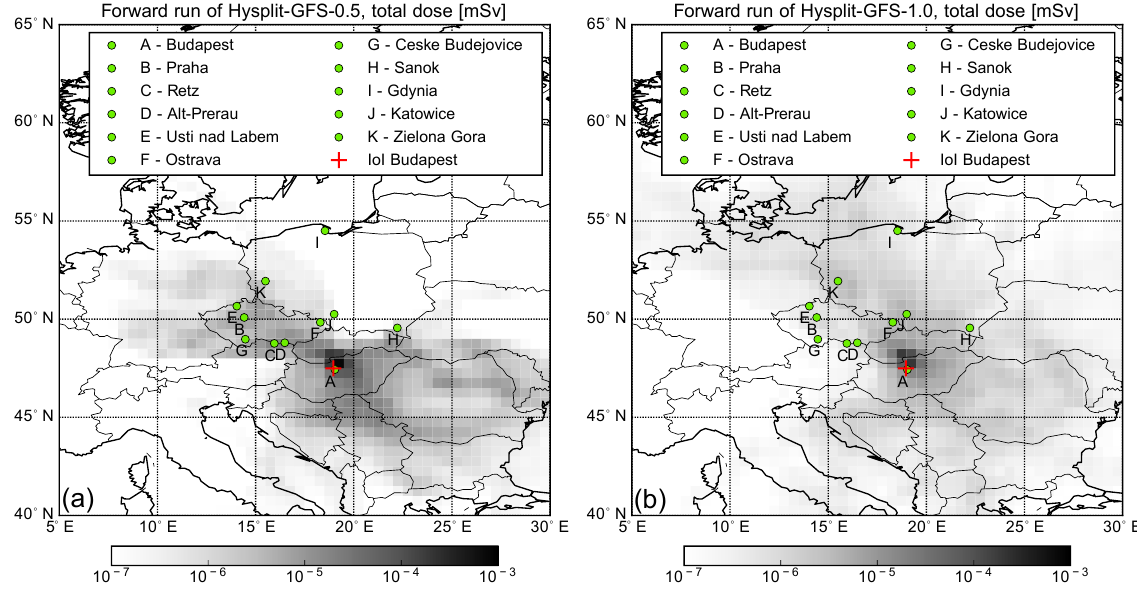
Figure 7. 131 I total dose for the whole 3-month studied interval. (a) Simulation using the HYSPLIT model with GFS input data with 0.5 ◦ resolution and with the source term computed using the LS-APC-VB algorithm given in Fig. 3, top right. (b) Simulation using the HYSPLIT model with GFS input data with 1.0 ◦ resolution and with the source term computed using the LS-APC-GS algorithm given in Fig. 5, bottom